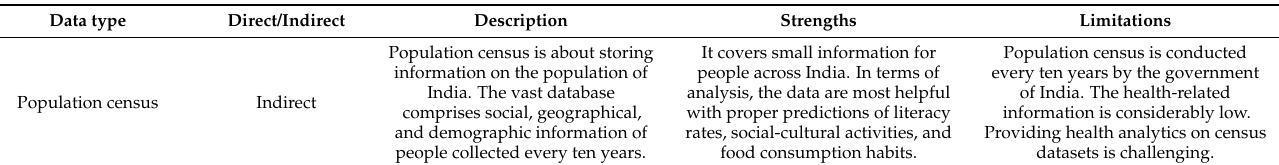
Table 6. Sources of the Indian healthcare